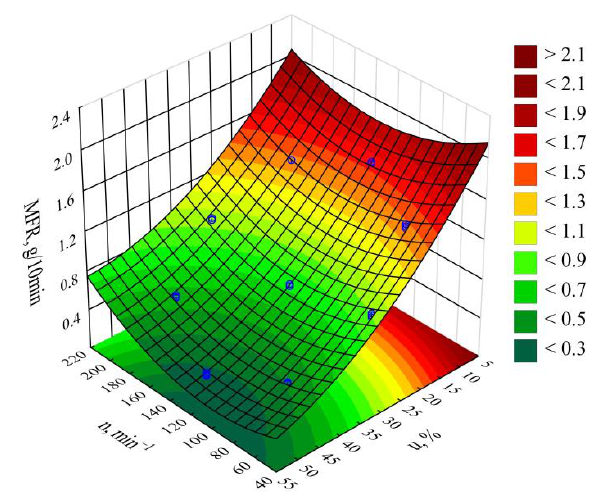
Figure 18. MFR response surface graph depending on the wheat bran content u and screw rotational speed n.